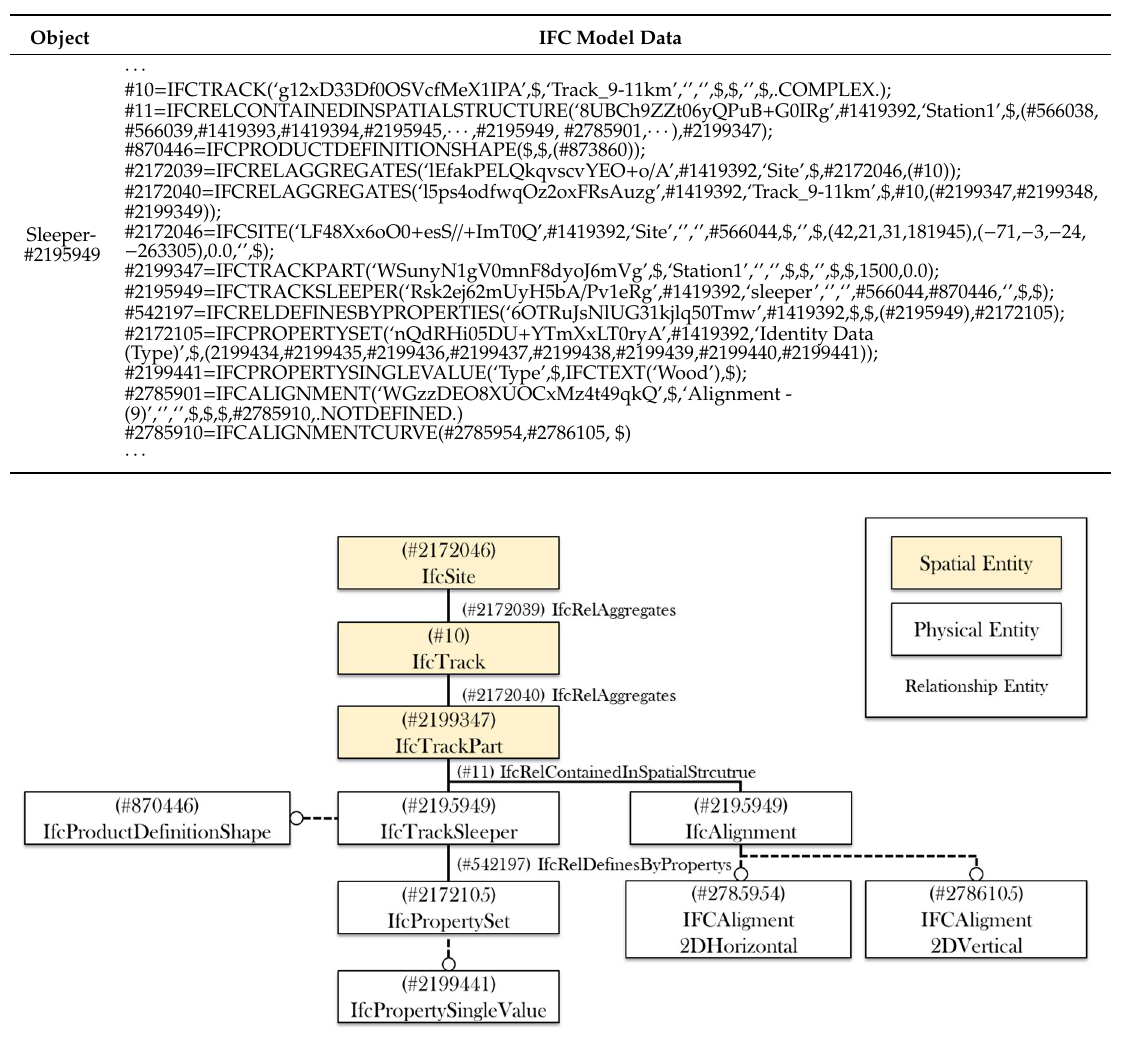
Table 3. IPF of the IFC-based railway track model.